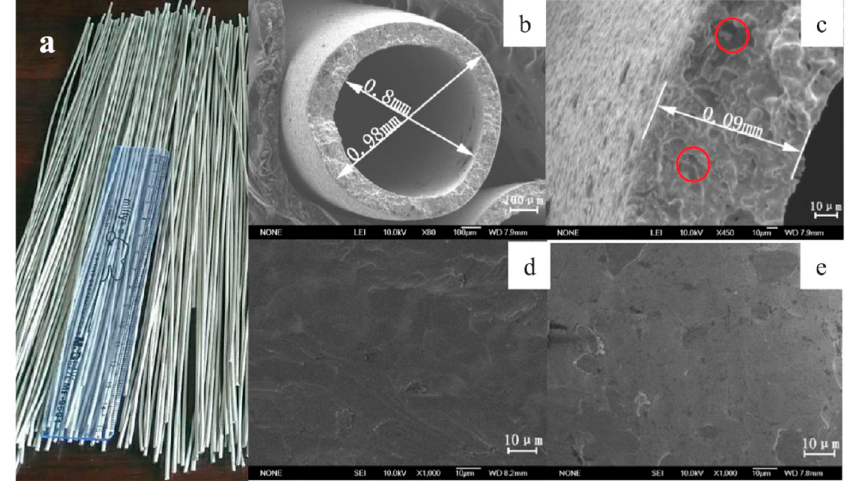
Figure 13. Photo of a bundle Ni hollow fibers ( a ); SEM images of the nickel hollow fiber membrane (sintered at 1200 °C for 3 h) ( b )-cross-section; ( c )-fiber wall; ( d )-inner surface; ( e )-outer surface; From [44].